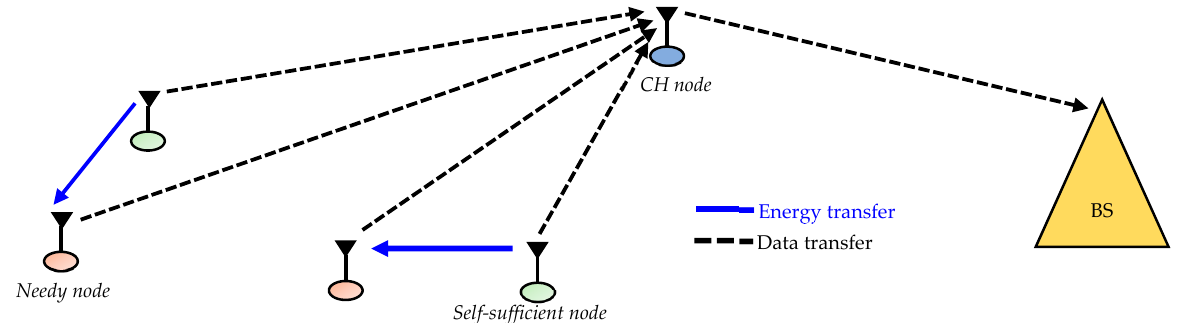
Figure 2. Energy assistance model between the different WS.